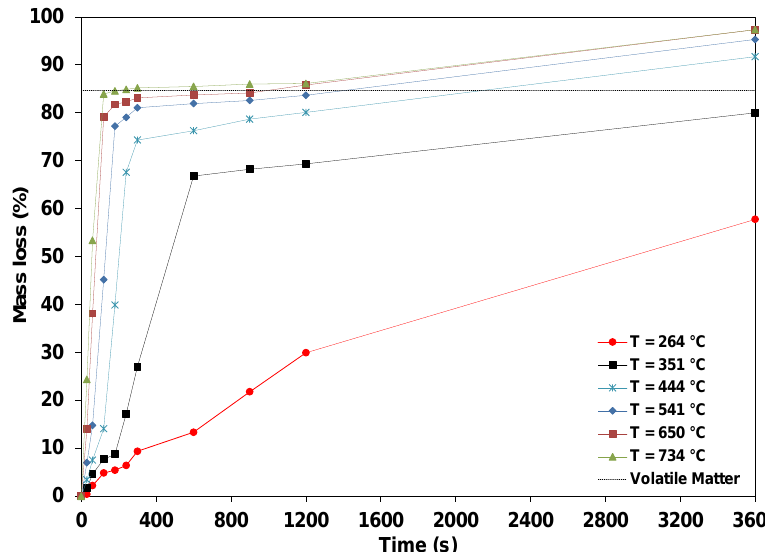
Figure 2. Mass loss of wood pellets vs time at temperature 264–734 °C.